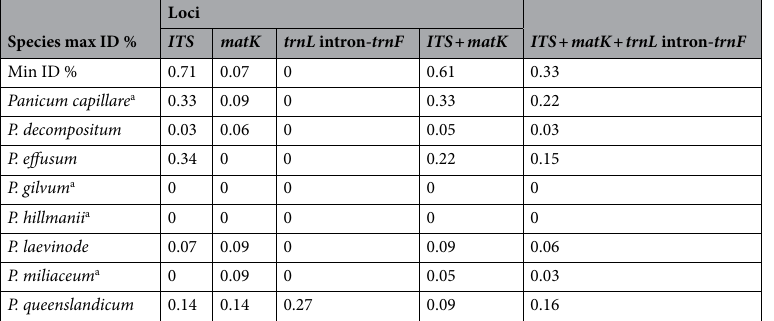
Table 2. Intraspecific and interspecific K2P distances for the three gene loci ITS , matK , trnL intron -trnF in eight Panicum species. Panicum buncei and P. coloratum were not included in this table because of overlap in respective DNA barcodes. Minimum interspecific distance, MinID; Maximum intraspecific distance, MaxID. Non-native species are denoted with a